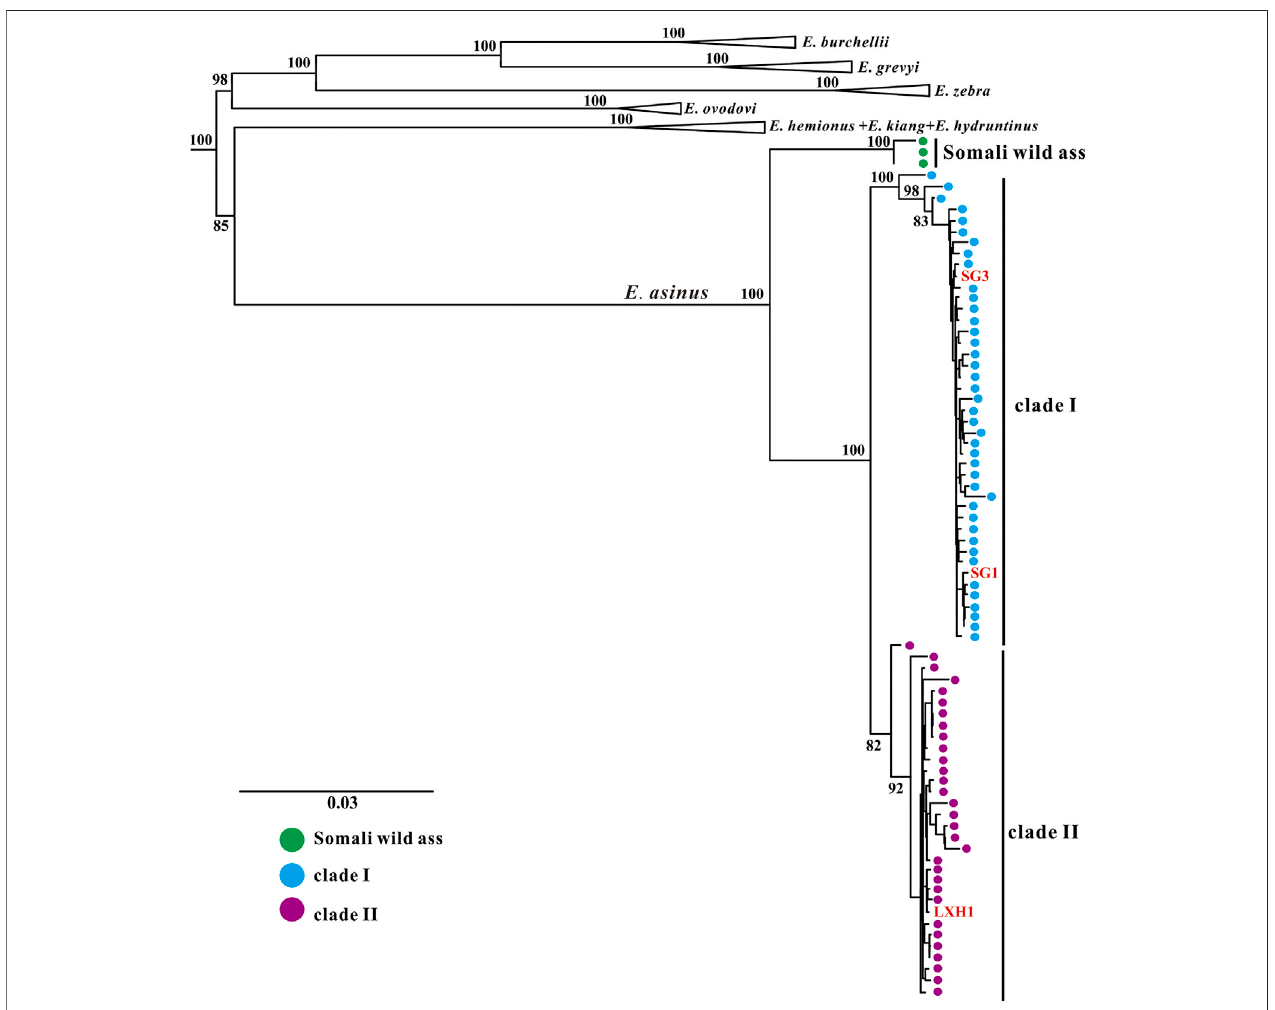
FIGURE2| Maximum-likelihoodphylogenetictreeofthegenusEquusbasedonnear-completemitochondrialgenomes. E.caballus wasselectedasoutgroup(not shown here). Branch labels show bootstrap values derived from 1,000 replications.